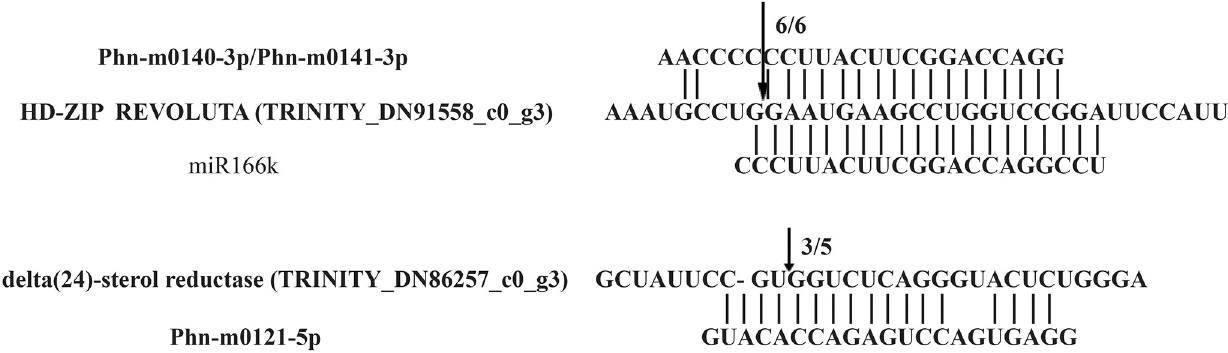
Fig 11. Cleavage sites identified by 5 0 RLM-RACE. Cleavage site of targets unigenes were labeled by the arrows. Different fractions of cloned PCR products were labeled with the